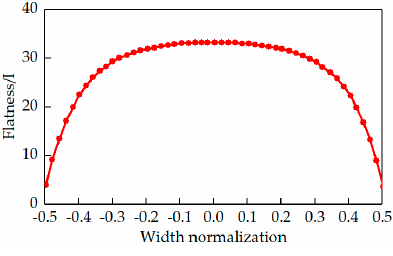
Figure 6. Strip flatness target curve.